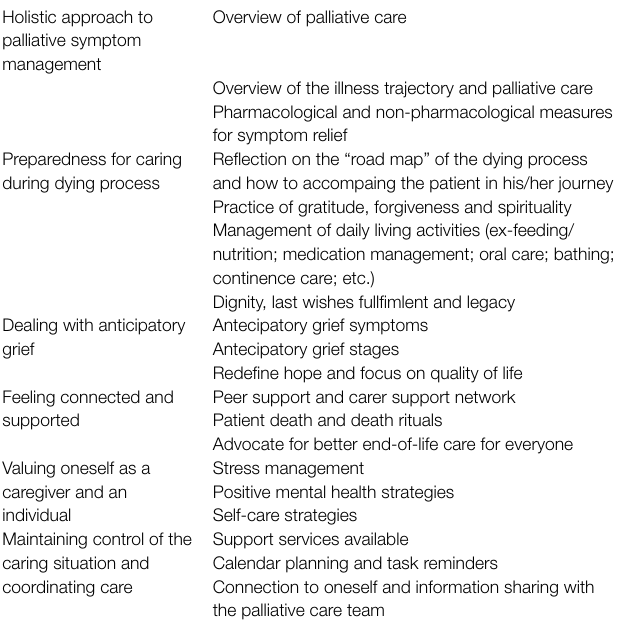
TABLE 1 | The content of the mhealth